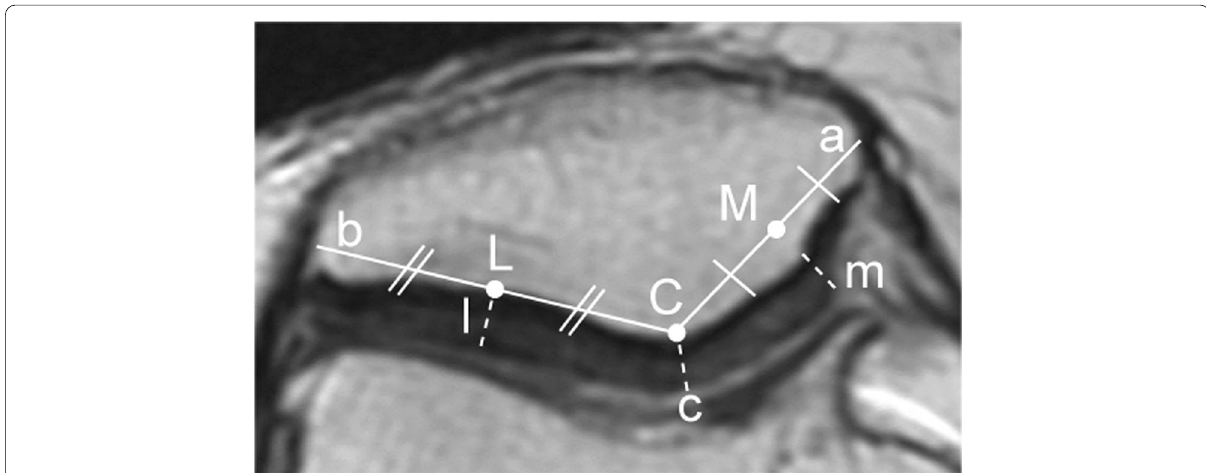
Fig. 1 Method of measuring patellar cartilage thickness using an axial single MRI image [a] is a line from the medial edge of the patella to the central edge of the patella; [b] is a line from the lateral edge of the patella to the central edge of the patella; [C] is the central edge of the patella; [M] is the midpoint in line [a]; [L] is the midpoint in line [b]. Dotted lines [c], [m], and [l] represent the cartilage thickness in the central, medial, and lateral facets, respectively. MRI, magnetic resonance imaging